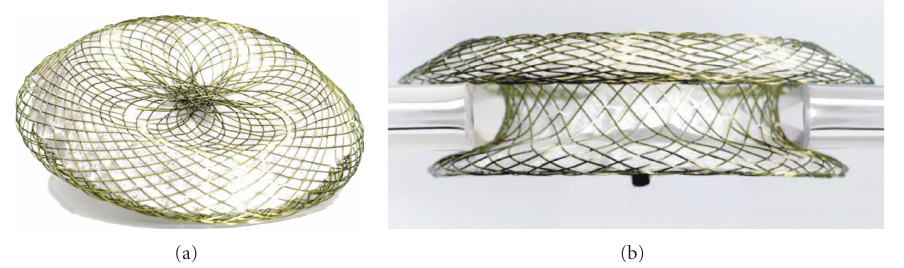
Figure 1: Occlutech Figulla R ASD device.